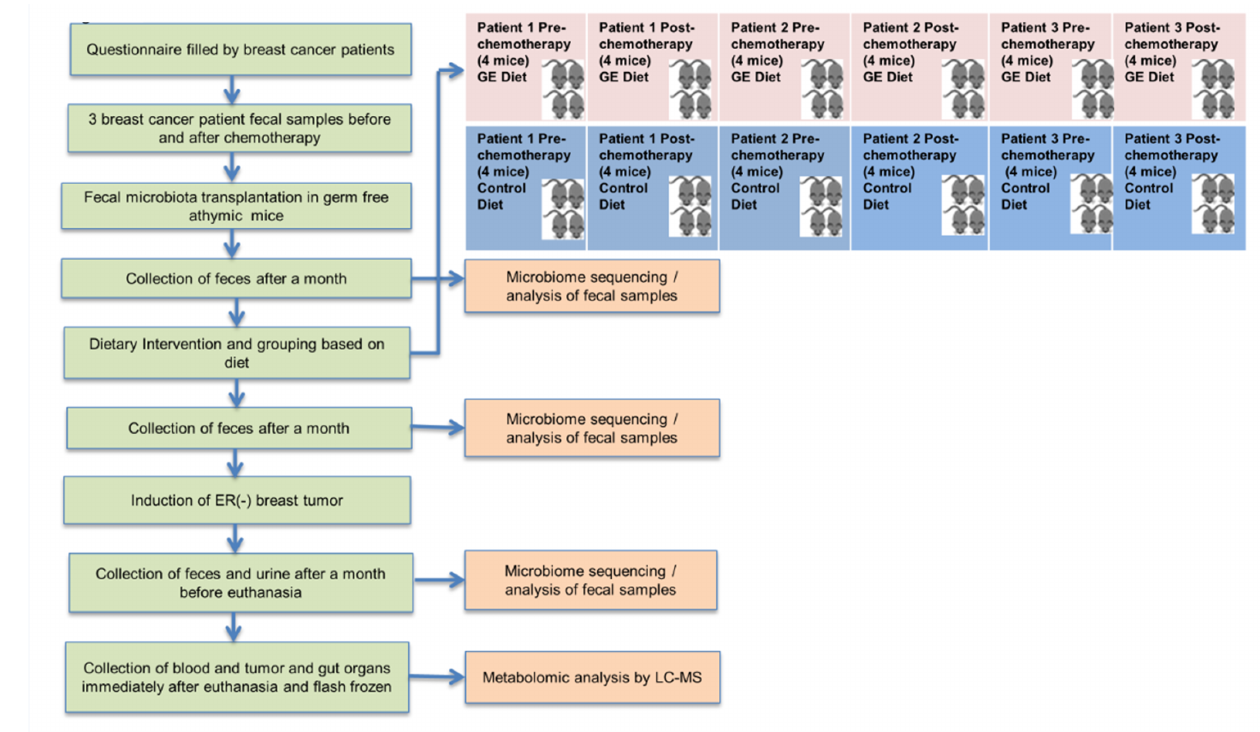
Fig 2. Study design flowchart. Breast cancer patients on chemotherapy (DOX and docetaxel)were recruited for the study. Fecal sampleswere obtainedfrom three breast cancer patients before and after chemotherapy and transplanted into germ-free athymic mice. Feces were collected from mice after a month and comparedwith fecal donor samples by performing microbiomeanalysis. The second stage of the project involved groupingmice basedon diets. Mice were fed GE diet or control diet and groupedinto different cages based on diet and chemotherapy as shown. Feces were collectedfrom mice two weeks and four weeks after start of diet and fecal microbiome analysiswas performed to comparethe microbiomechangesin the distinct groups. The third stage of the project involvedinductionof ER (-) breast tumor in mice. Feces and urine were collected after tumor size reached1 cm 3 one day before euthanization. On the day of euthanization,blood and tumor were collectedand flash frozen for metabolomic and